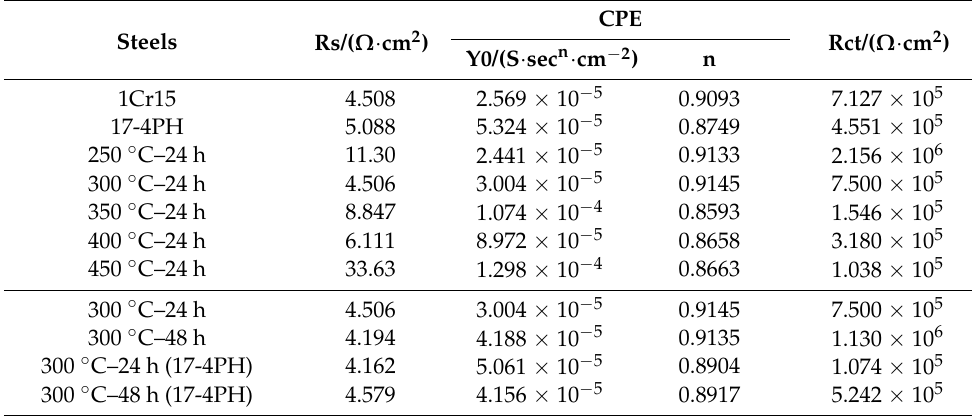
Figure 13. Impedance equivalent circuit diagram of stainless steel with different nitriding times. Table 7. Fitting parameters of components of EIS equivalent circuit.